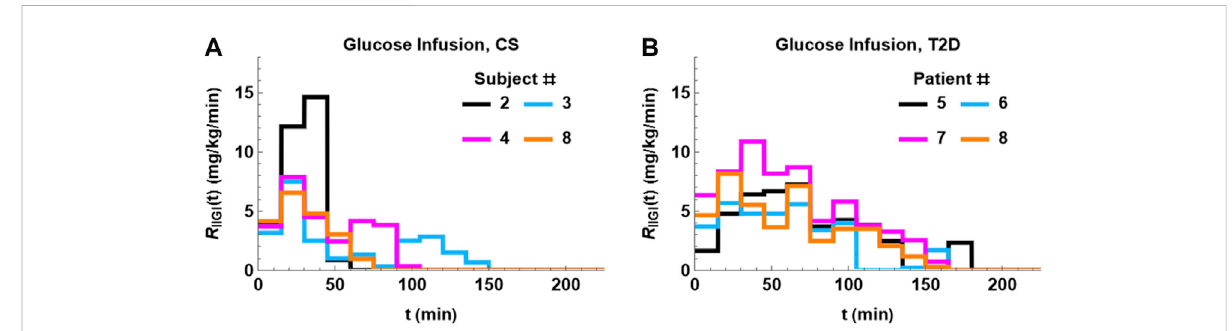
FIGURE 2 Glucose arrival pro fi les, R IIGI , determined using Eq. 6. There is signi fi cant difference between the pro fi les both within groups and between groups. The pro fi les tend be more bimodal in CS subjects (A) . The glucose arrival pro fi le for T2D (B) is unimodal and more prolonged relative to